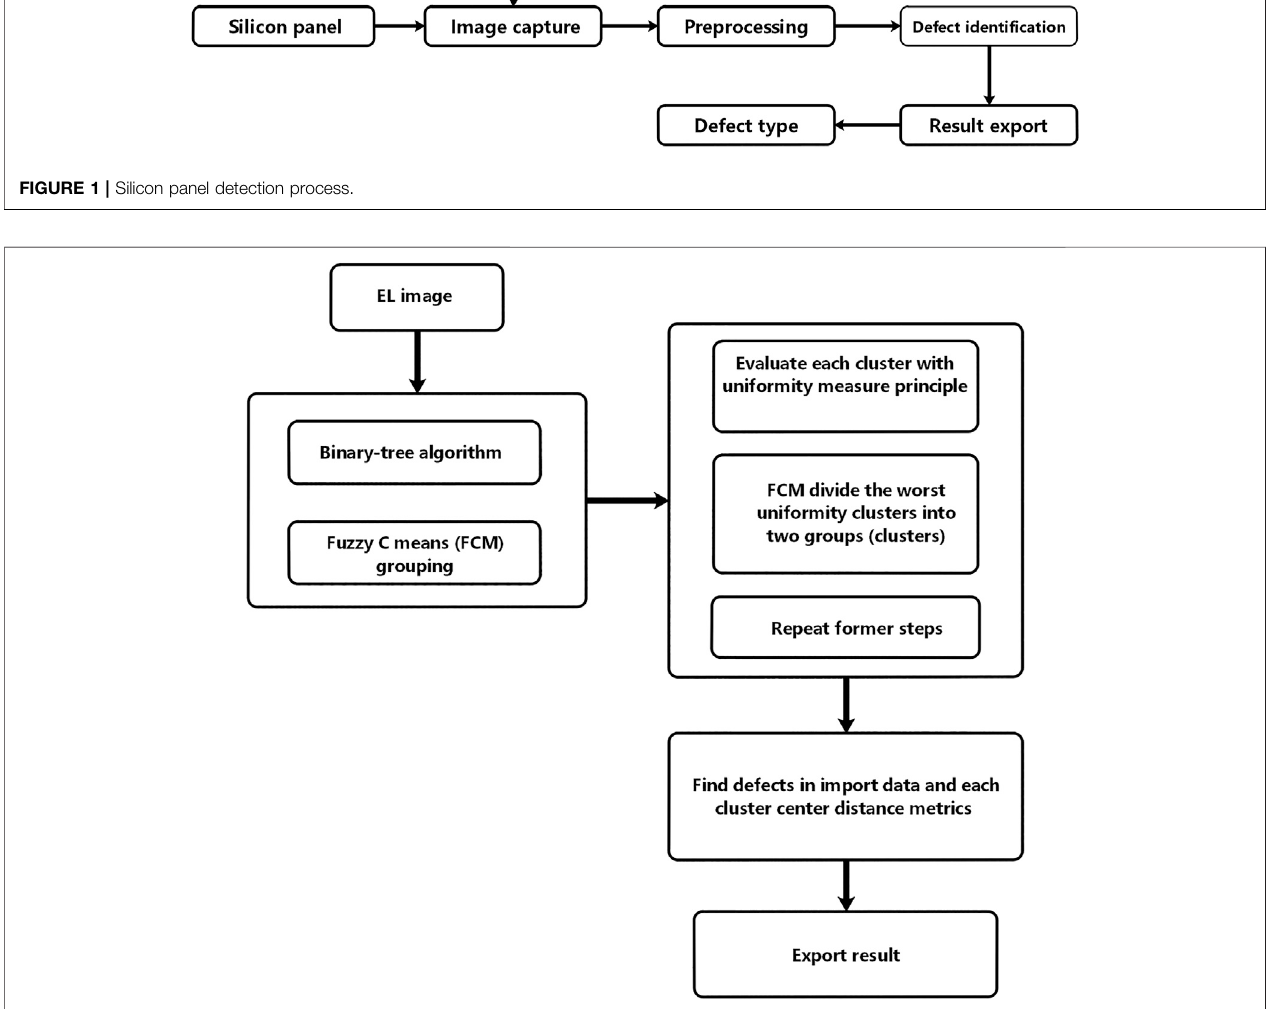
FIGURE 2 | Clustering method process for silicon panel